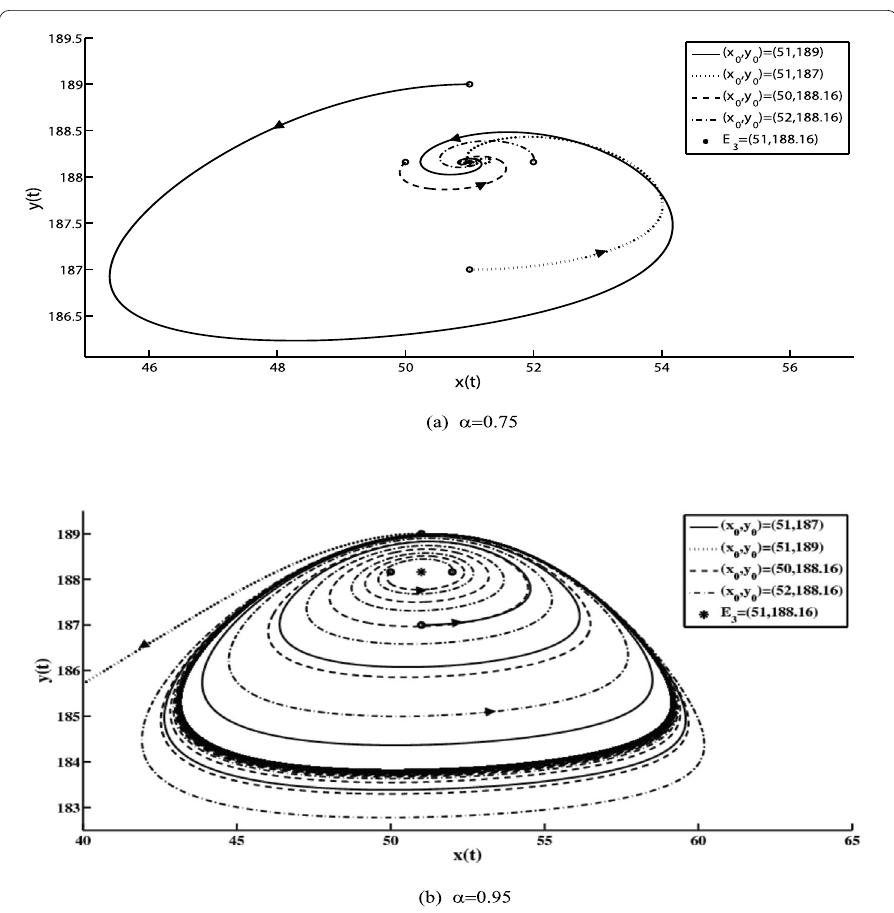
Figure 3 Dynamic behavior of model (3) with several initial conditions and the following parameters: s = 102, r = 8, K = 100, m = 3, a = 51, p = 2, and c = 1. ( a ) Derivative order α = 0.75 and ( b ) derivative order α =